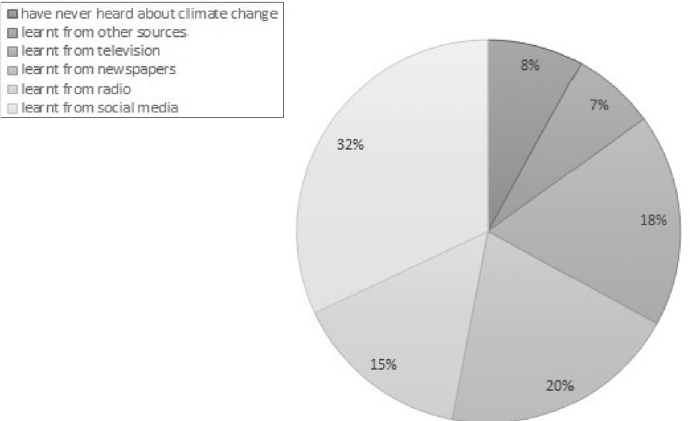
Figure 1. Percentage (%)